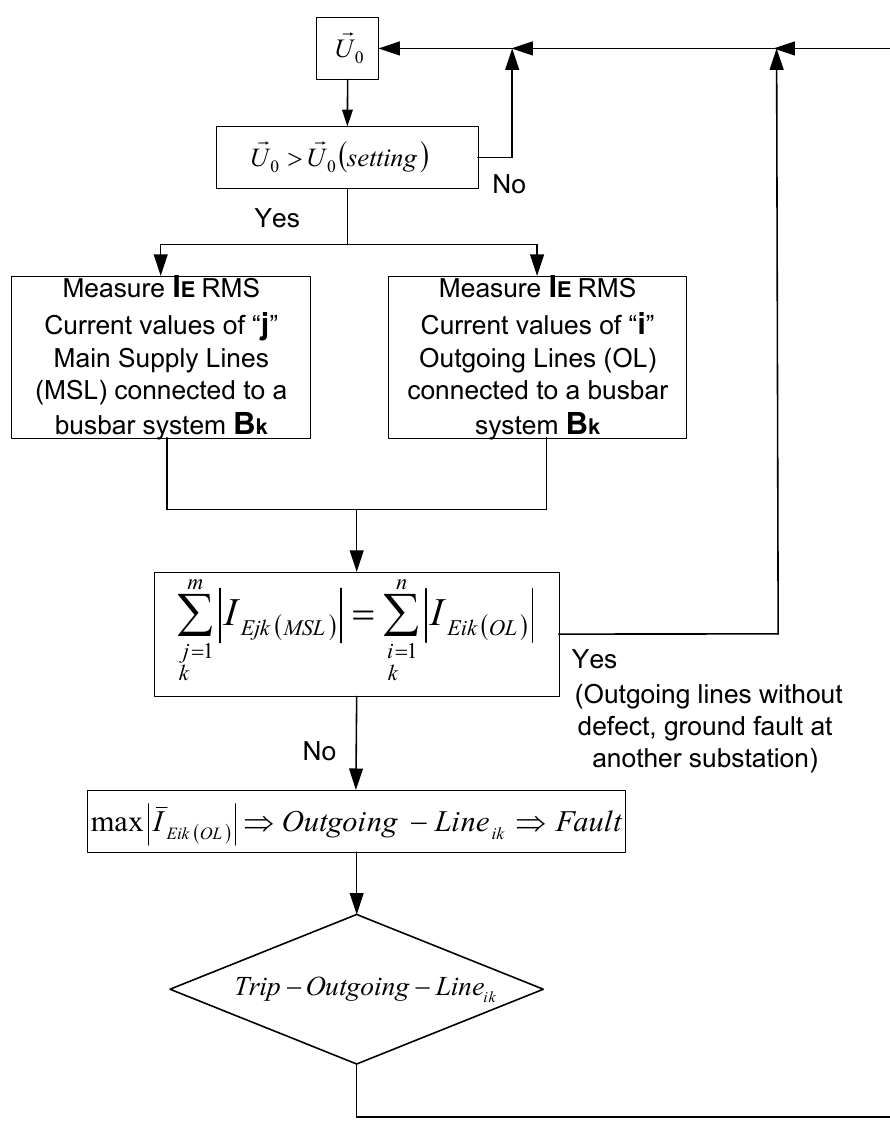
Figure 8. Secondary substation. Algorithm for SPGF